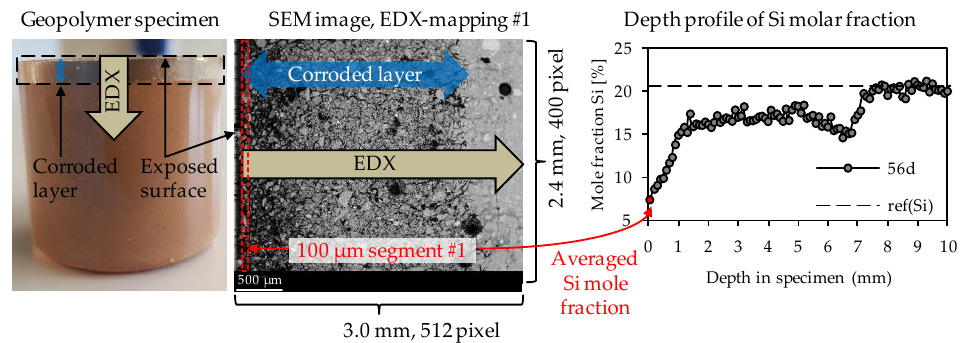
Figure 2. Direction of EDX-mappings, position of 1st 100 µm segment of EDX-mapping and depth profile of EDX mole fractions, exemplified for silicon.